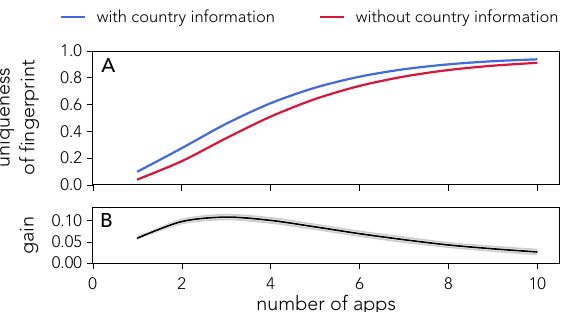
Figure 6. Increased re-identifiability from adding demographic information. ( A ) The average fraction of unique individuals, estimated using the random attack scheme, as a function of the number of apps n sampled from the fingerprint, when information about individuals’ country is included (blue line) or not (red line). To exclude effects due to how users are distributed across countries in our dataset, we create a synthetic dataset that includes a random sample of 20,000 individuals from each of the countries under study (see Fig. 4). ( B ) Gain in rate of re-identification when the country information is included. The gain peaks at n = 3